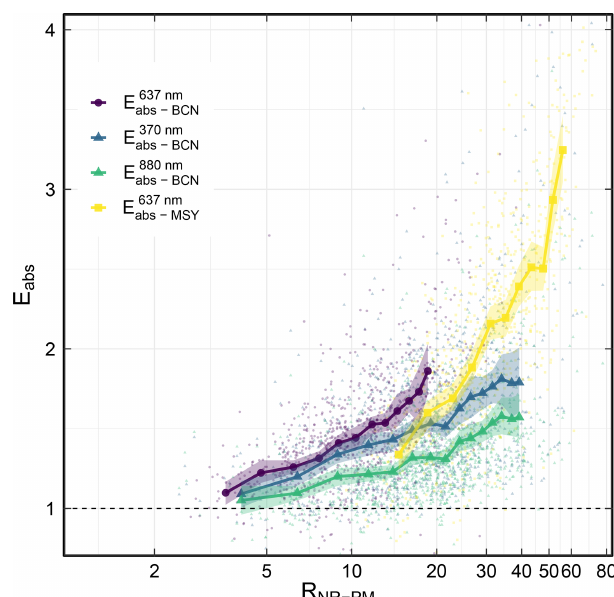
Figure 3. Absorption enhancement ( E abs ) as a function of the NR- PM to EC ratio at the Barcelona (BCN) and Montseny (MSY) sta- tions. The offline E abs measurements with a PM 10 inlet at 637nm were used for both BCN and MSY. Also, at BCN, online E abs mea- surements with a PM 2 . 5 inlet at the short UV (370nm) and NIR (880nm) wavelengths were used. The scatter points represent all the measurements, whereas the marked points show the mean of each bin, whilst the shadow of the line represents the standard deviation of each